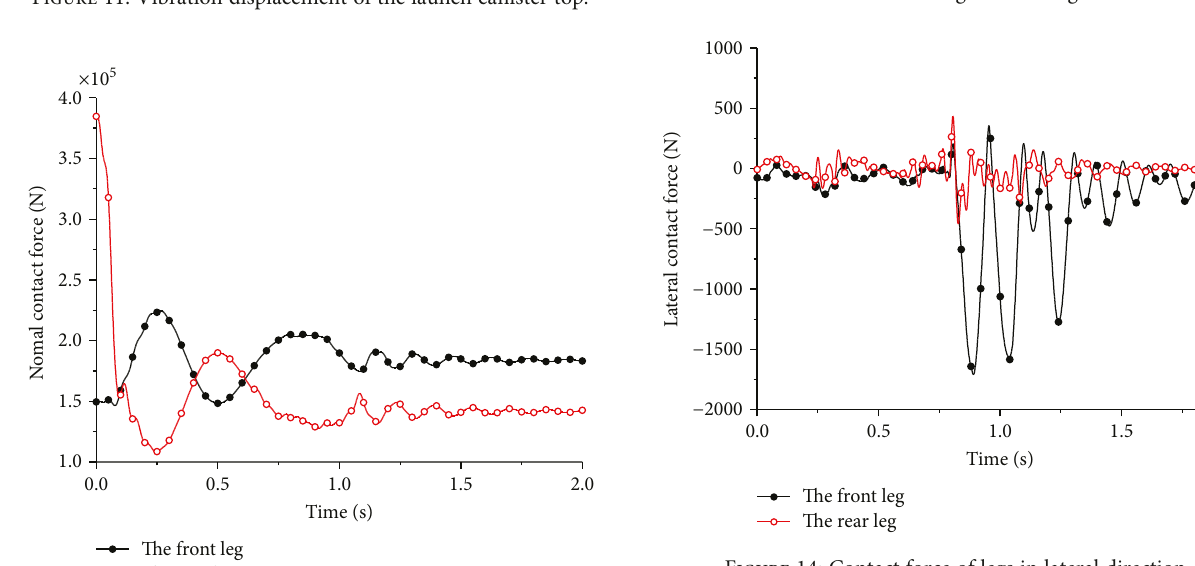
Figure 13: Contact forces of legs in the longitudinal direction.